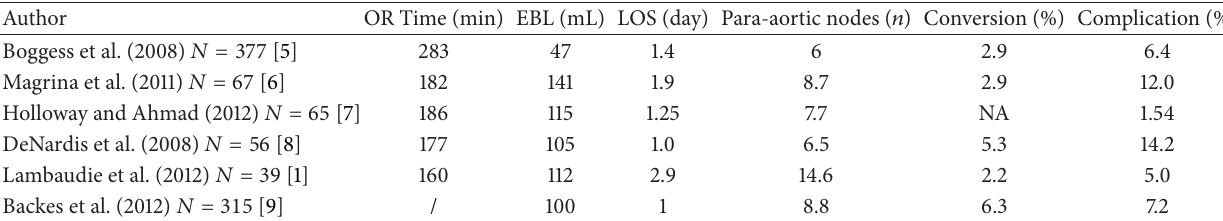
Table 5: Literature